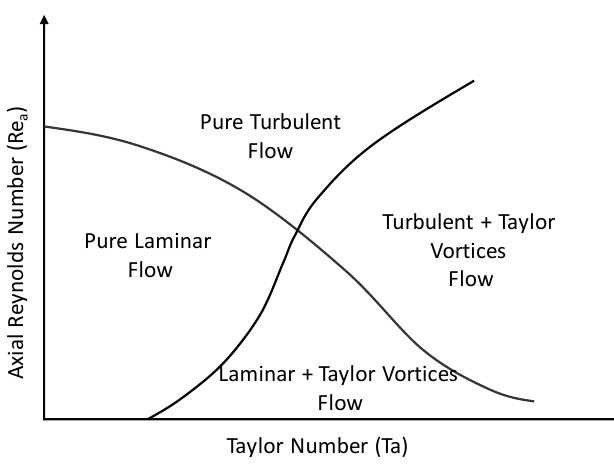
Figure 2. Different flow modes in annulus with inner cylinder rotating.